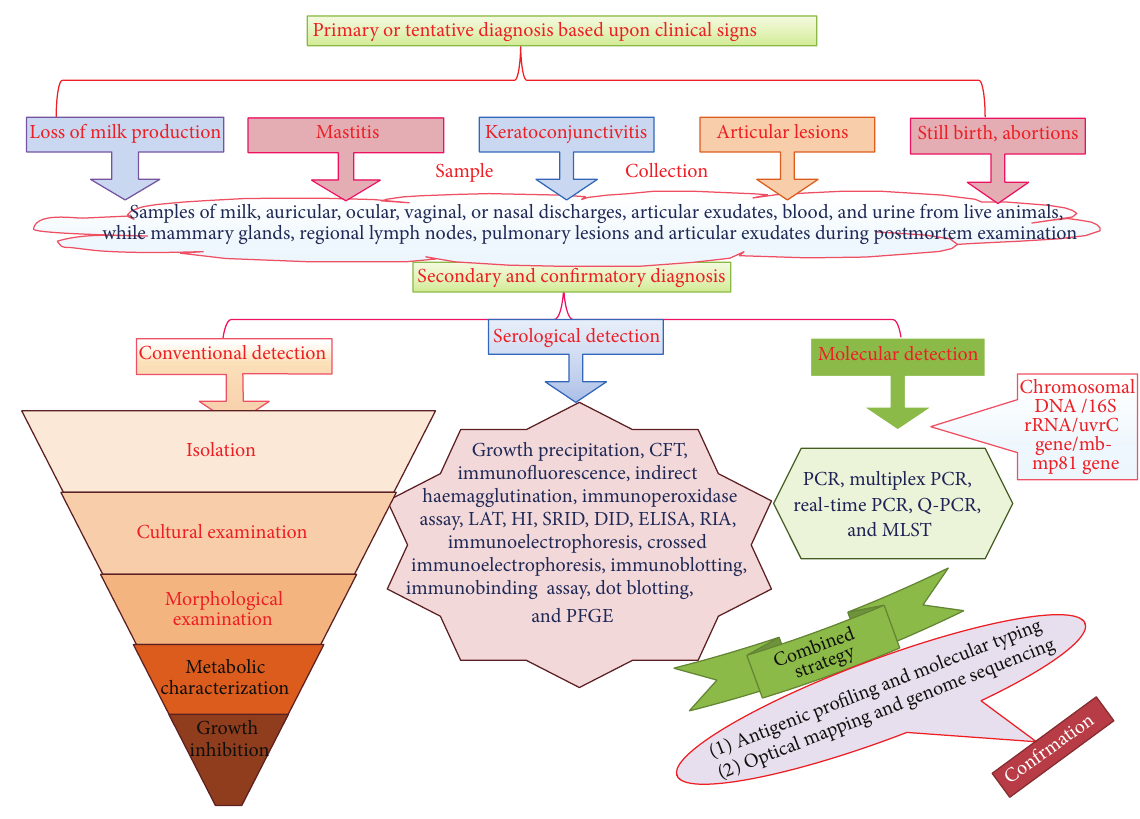
Figure 2: Diagnosis of Mycoplasma agalactiae